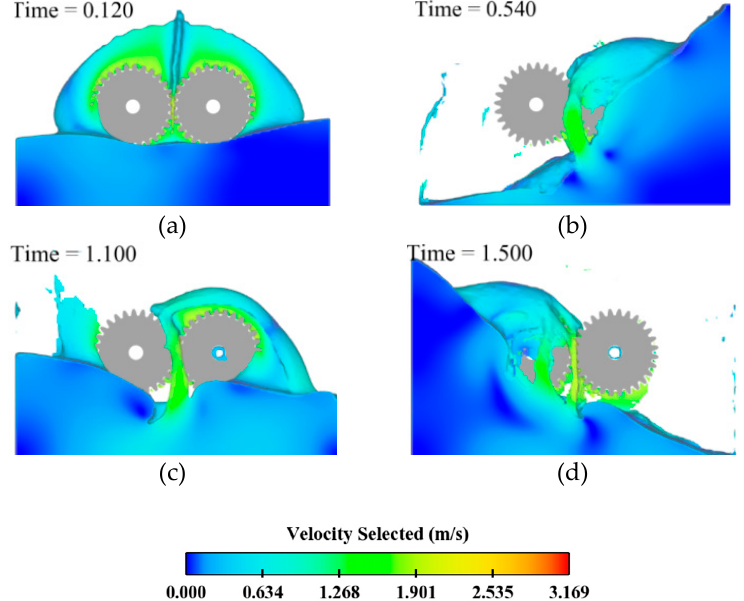
Figure 8. Oil free surface and velocity distribution at di ff erent time points. ( a ) Time = 0.120 s; ( b ) Time = 0.540 s; ( c ) Time = 1.100 s; ( d ) Time = 1.500